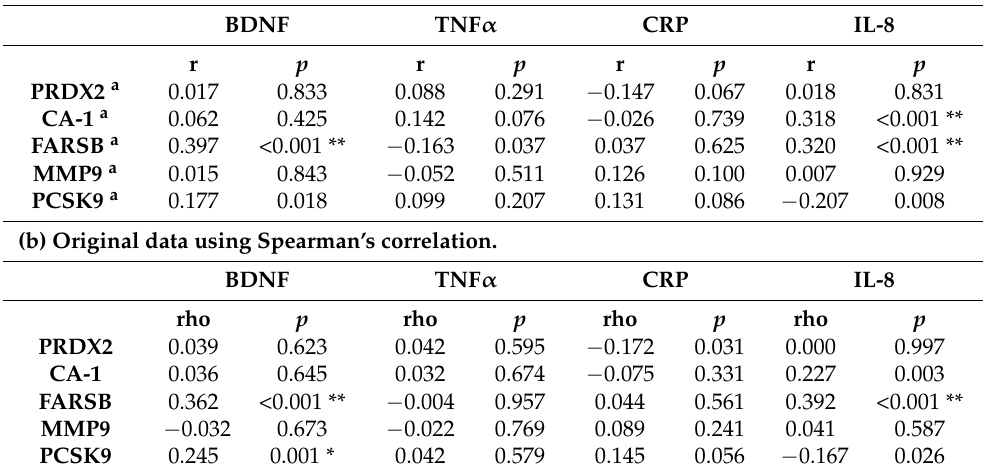
Table 2. Correlation between level of protein levels and cytokine and BDNF in BD-II. (a) Log-transformed data using Pearson’s correlation.